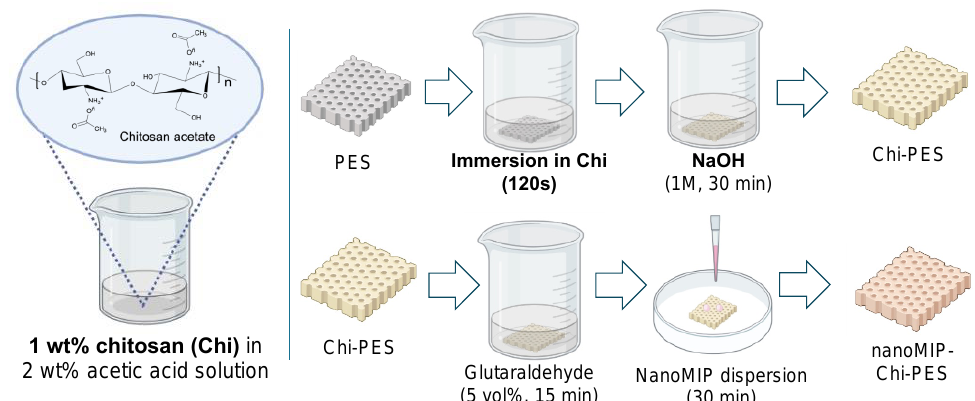
Figure 1. Schematic representation of the main modification steps of polyethersulfone (PES) mem- brane with chitosan (Chi) and the immobilization of molecularly imprinted nanoparticles (nano- MIPs).